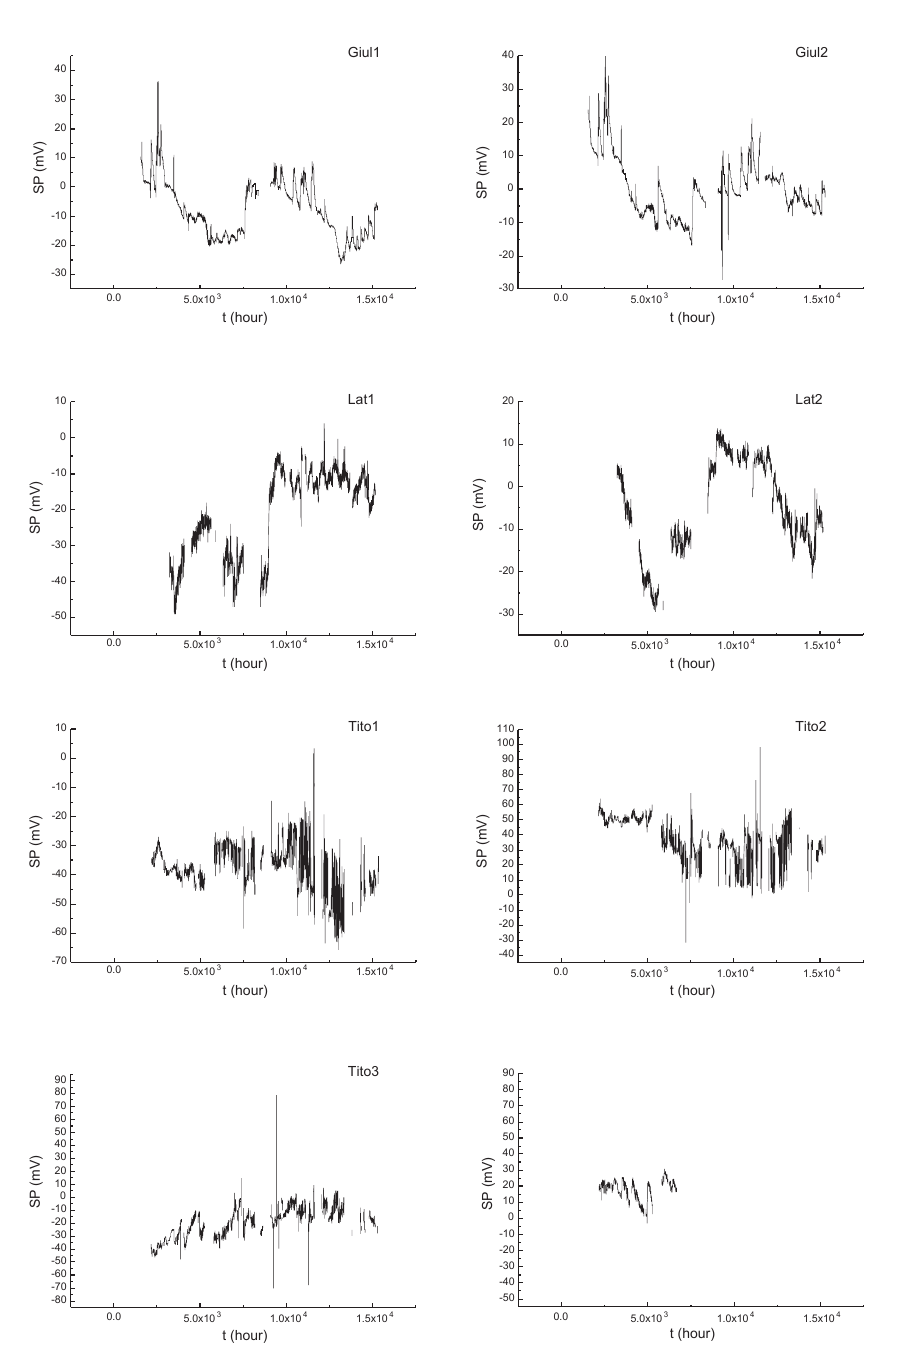
Fig. 2. Hourly variability of the 8 geoelectrical signals recorded at stations Giuliano, Laterza and